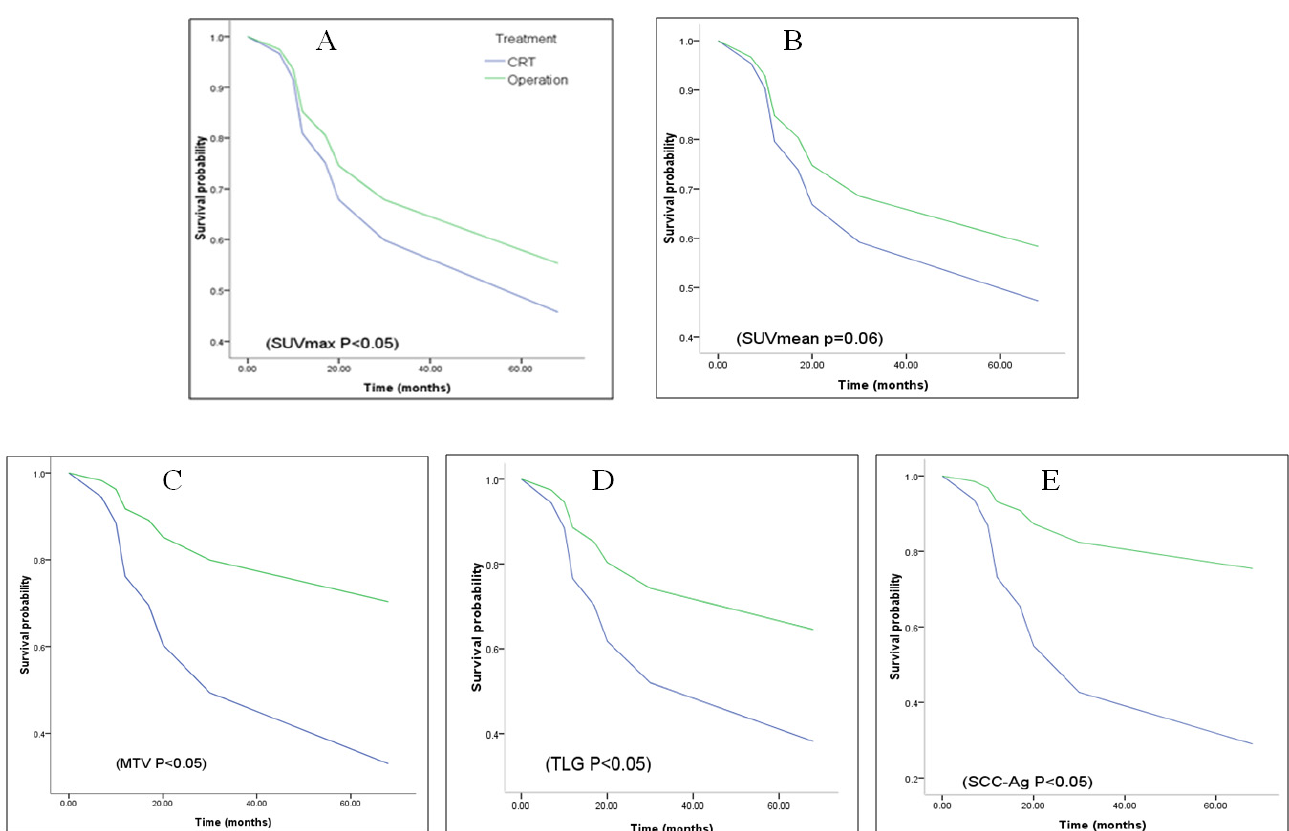
Figure 2. Kaplan–Meier curves of different tumor metabolic parameters for overall survival of patients. ( A ) SUVmax, ( B ) SUVmean, ( C ) MTV, ( D ) TLG, and ( E )